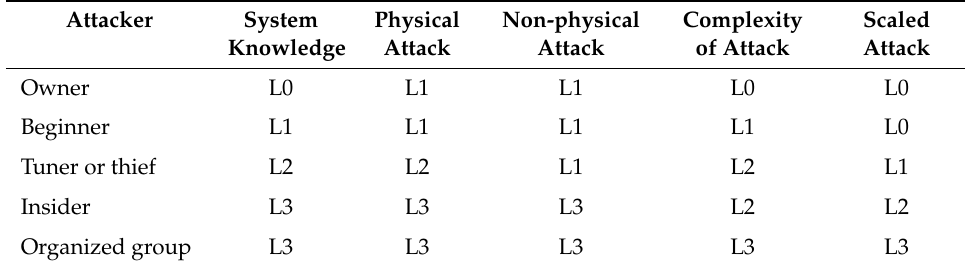
Table 1. Attacker classification using skill and knowledge